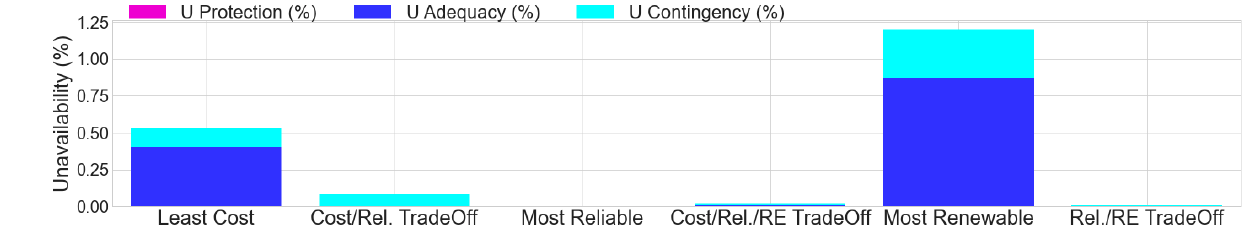
Figure 9. Sources of unavailability for the six selected configurations.